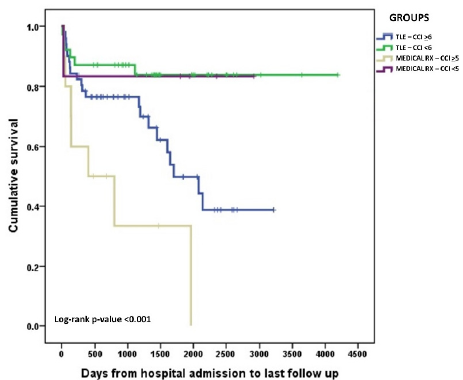
Figure 2. Kaplan–Meier curves describing long-term survival probability according to therapeutic approach (medical only vs. TLE) and CCI < or ≥ the group median.